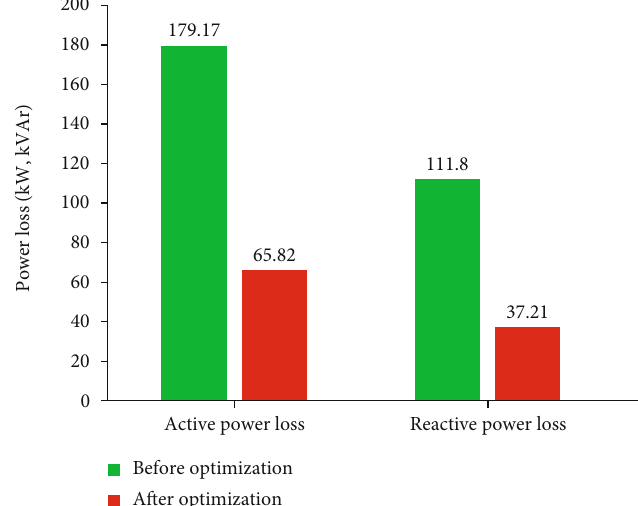
Figure 10: Power loss reduction after